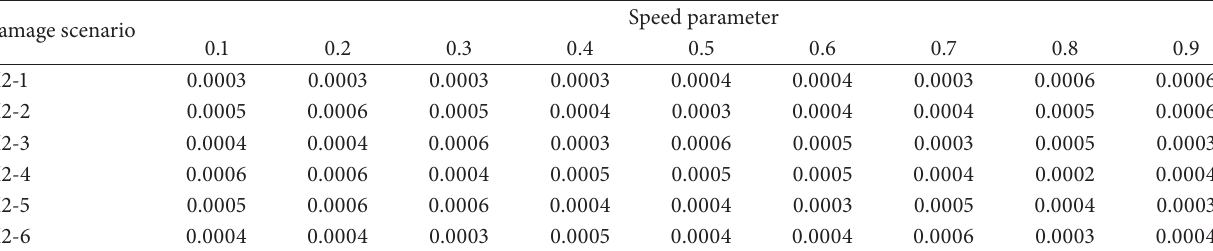
Figure 8: Plane grid bridge model used in detection procedure. Table 6: RPE of DDM method for model 2.